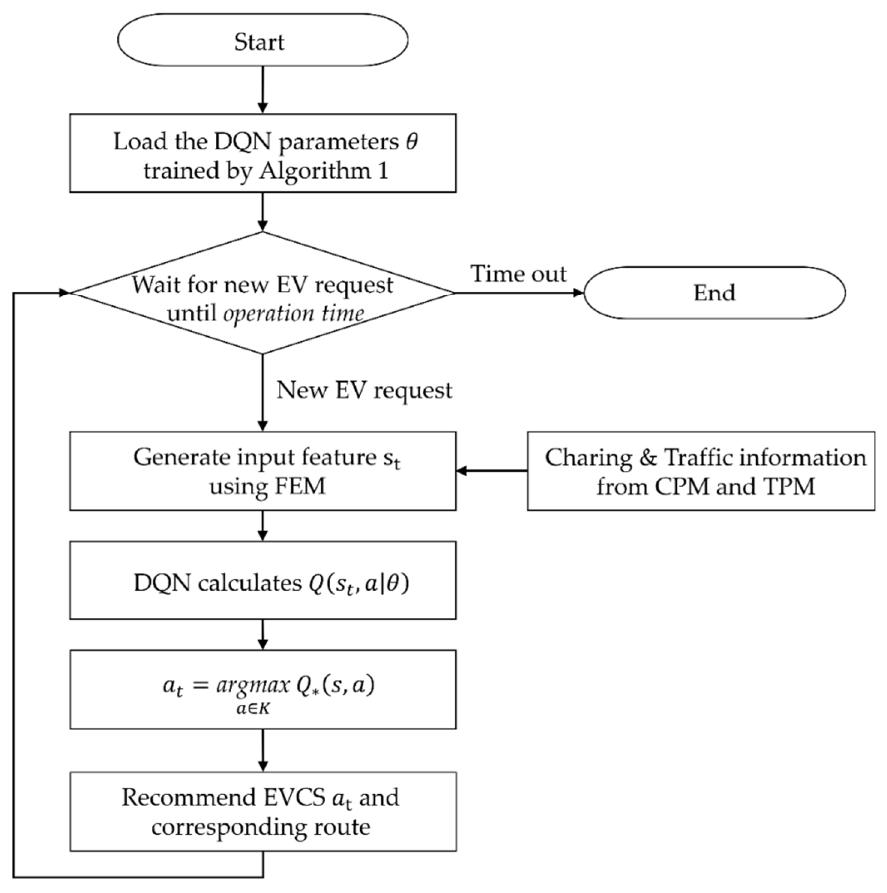
Figure 5. Flowchart of charging station selection.